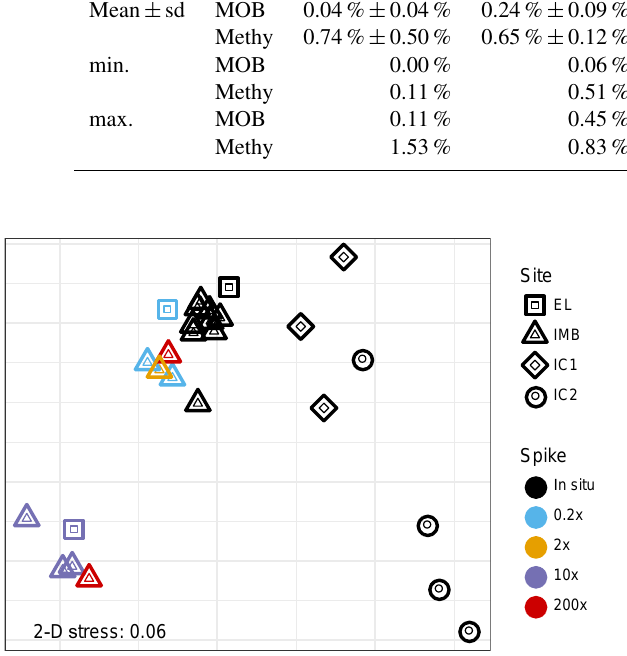
Figure 4. Non-metric multidimensional scaling analysis (unitless) of Bray–Curtis dissimilarities of the 16S read data. The low 2-D stress of 0.06 indicates a good two-dimensional representation of the multidimensional dataset with very low prospect of misinter-